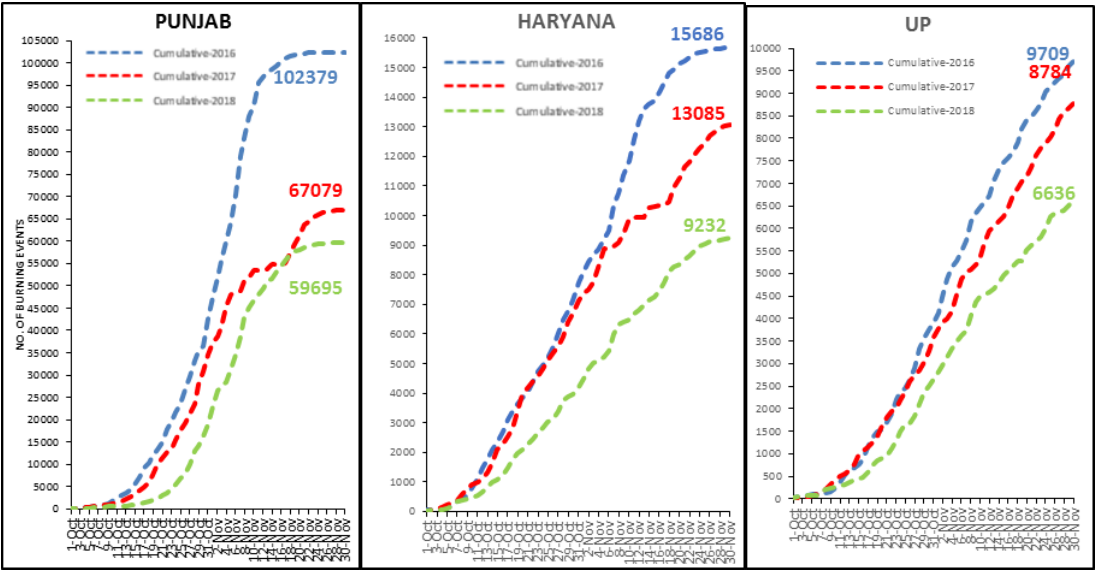
Figure 9. Comparison of burning events of 2018 with events in 2016 and